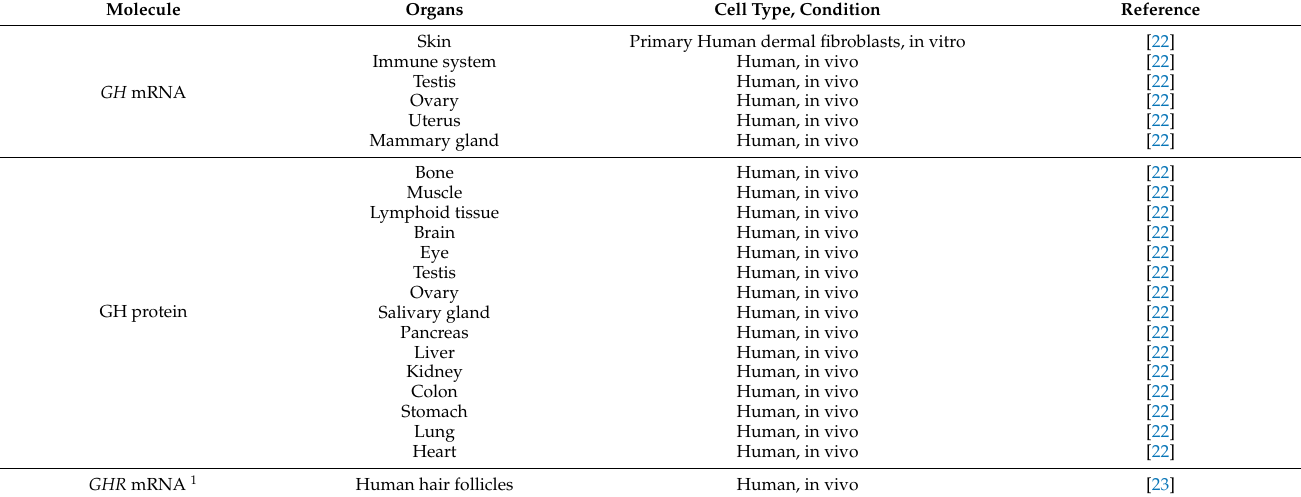
Human hair follicles Human, in